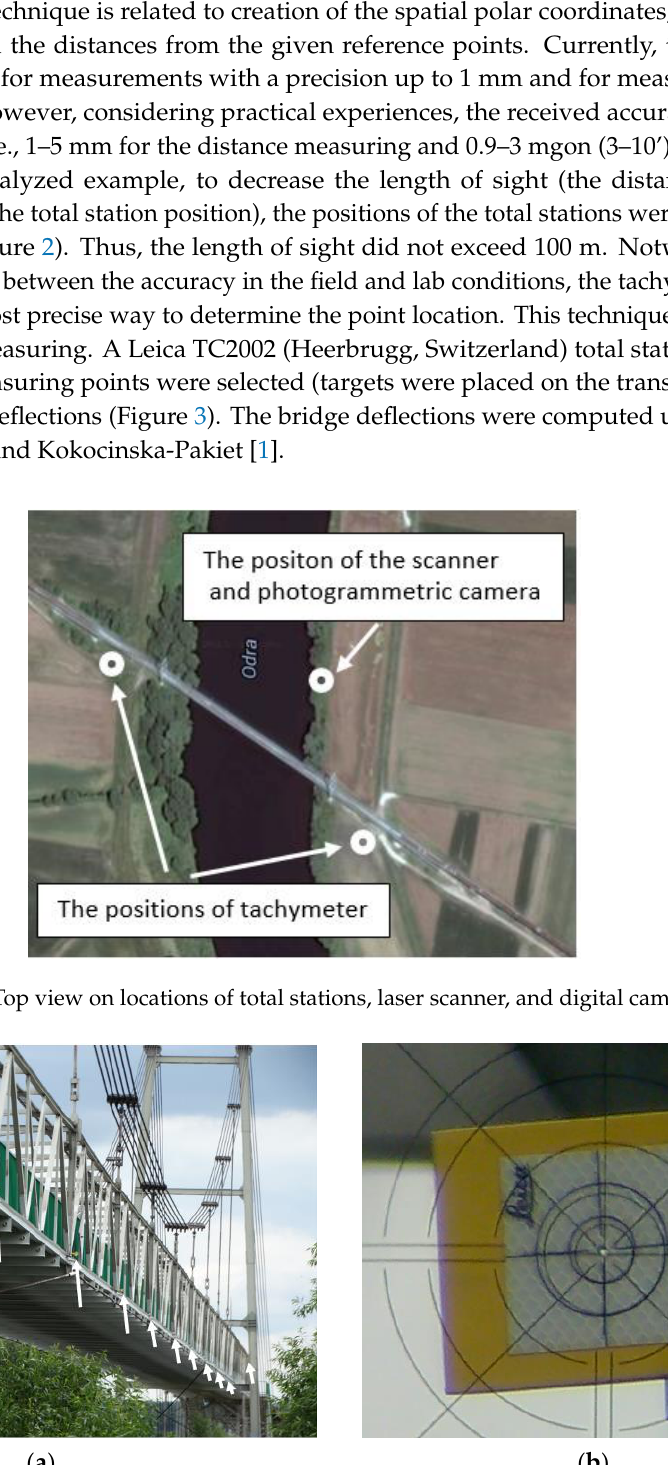
Figure 3. The examined bridge structure seen through the total station: ( a ) distribution of the measurement shields on the transport gallery, ( b ) view of the measurement shield through the telescope of the total station.